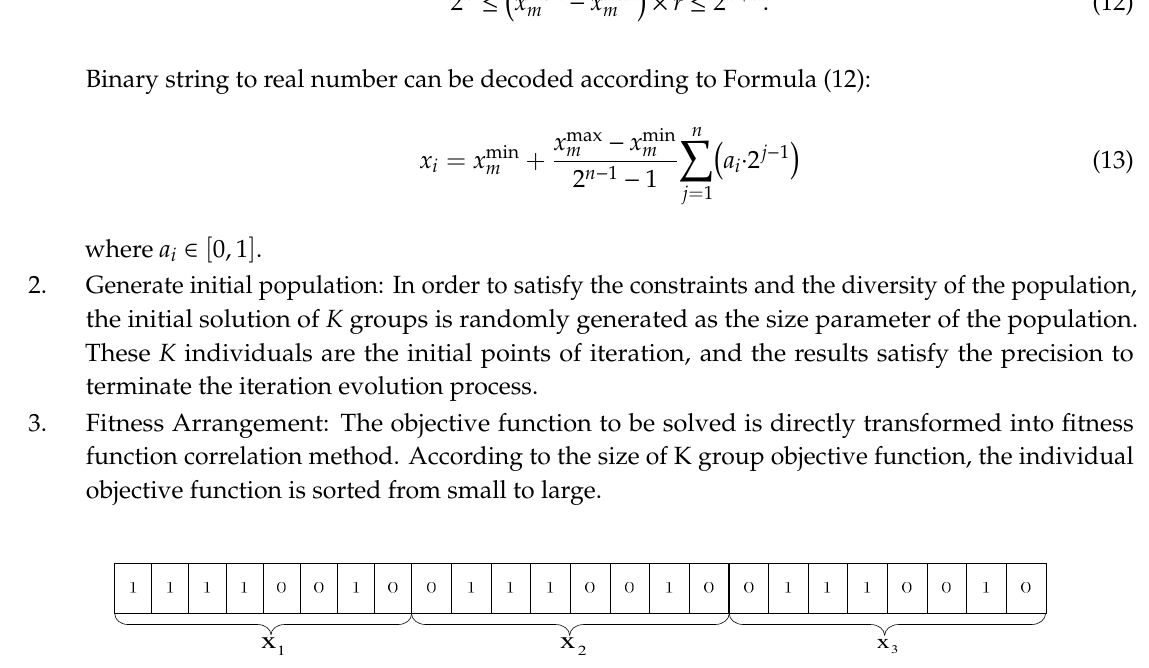
Figure 5. Binary representation in Genetic Optimization (GA).